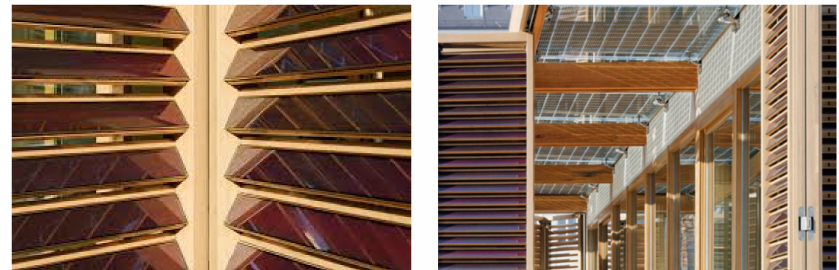
Figure 9. Technische Universität Darmstadt: ( Left ): BIPV in louvered oak shutters. Adapted from ref. [127]. ( Right ): BIPV awning. Adapted from ref.